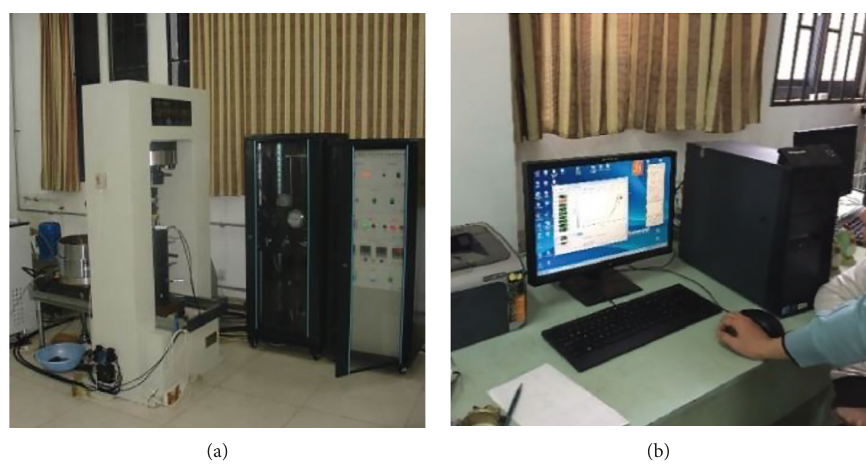
Figure 6: Sample and test equipment of compression.